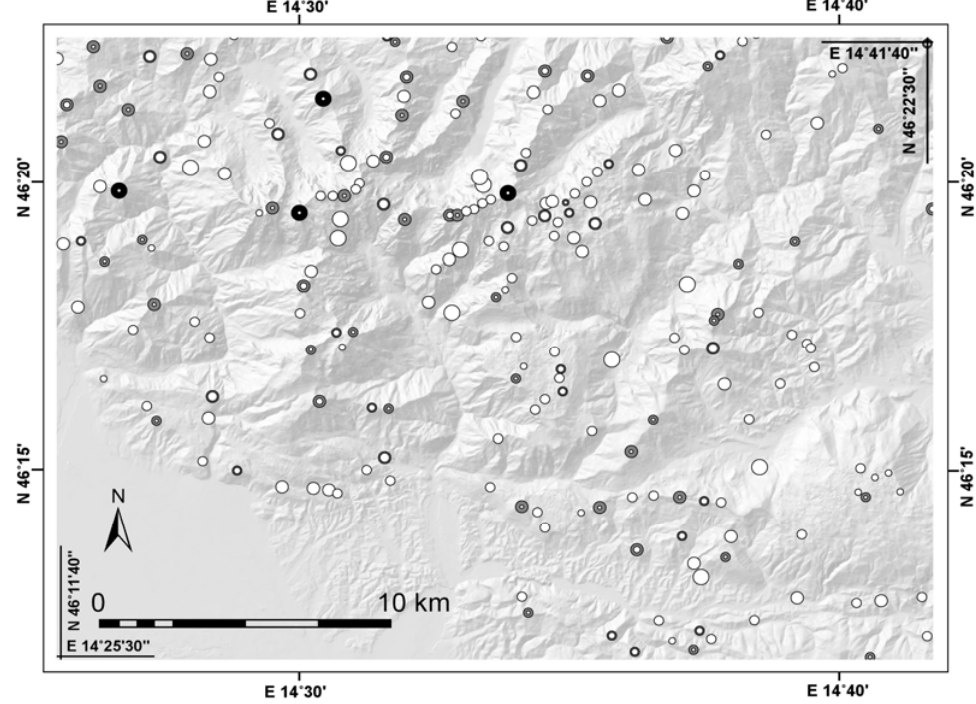
Figure 11. The extent of conical formation in regional peaks. Large black circles with small white dots denote evident “conicalness”, whilst smaller grey circles denote some degree of conical form, and the white circles of different sizes denote the peaks that are not